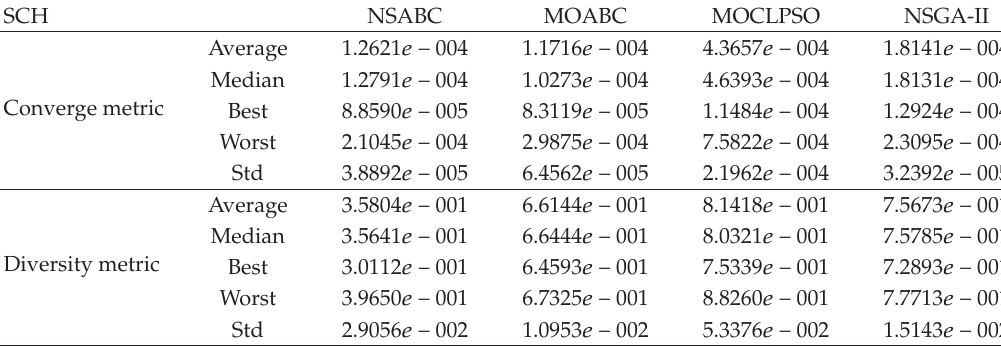
Table 1: Comparison of performance on SCH after 10000